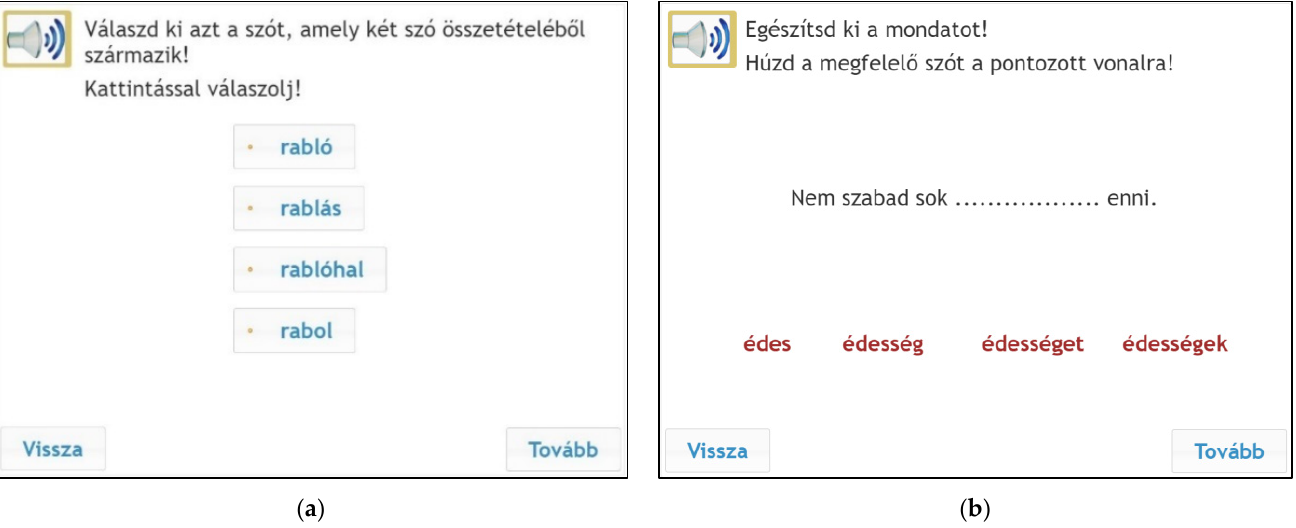
Figure 2. Sample items for compound words and derivation. Left ( a ): compound words, instruction: